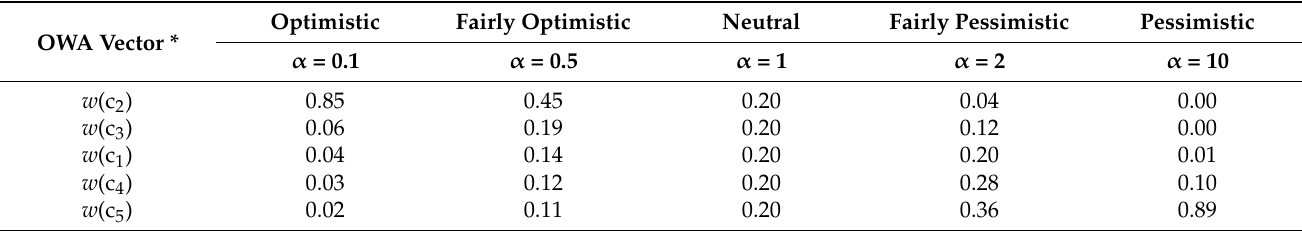
Table 9. OWA weighting vector ( w ).